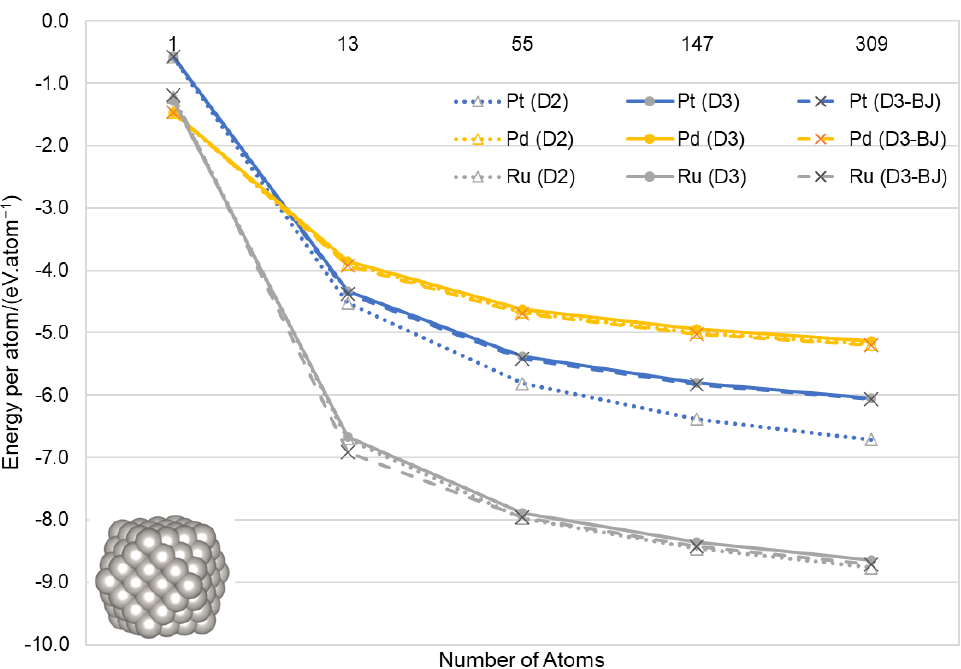
Figure 5. Energy per atom as a function of size for cuboctahedral Ru, Pd and Pt nanoparticles calculated with the three modelling methods, DFT-D2, DFT-D3 and DFT-D3(BJ). The energies as a function of increasing sizes of the cubic nanoparticles of Ru, Pd and Pt, calculated by the three modelling methods, DFT-D2, DFT-D3 and DFT-D3(BJ), are shown in Figure 6. Again, the energy per atom increases as the nanoparticle size increases, with the surface-to-bulk atom ratio again decreasing from 12.00 to 3.85, 1.71, 1.13 and 0.82 for G m = 13, 63, 171, 365 and 665, respectively. The number of bulk atoms exceeds the surface atoms at G m = 665. Once again, the three calculation methods gave similar results for Pd and Ru, with the DFT-D2 method deviating for Pt. As expected, extrapolation to larger nanoparticles indicates that the energy per atom would again reach values above − 5 eV/atom for Pd, − 6 eV/atom for Pt and − 8 eV/atom for Ru, which correlates with the bulk calculations shown in Table 1.